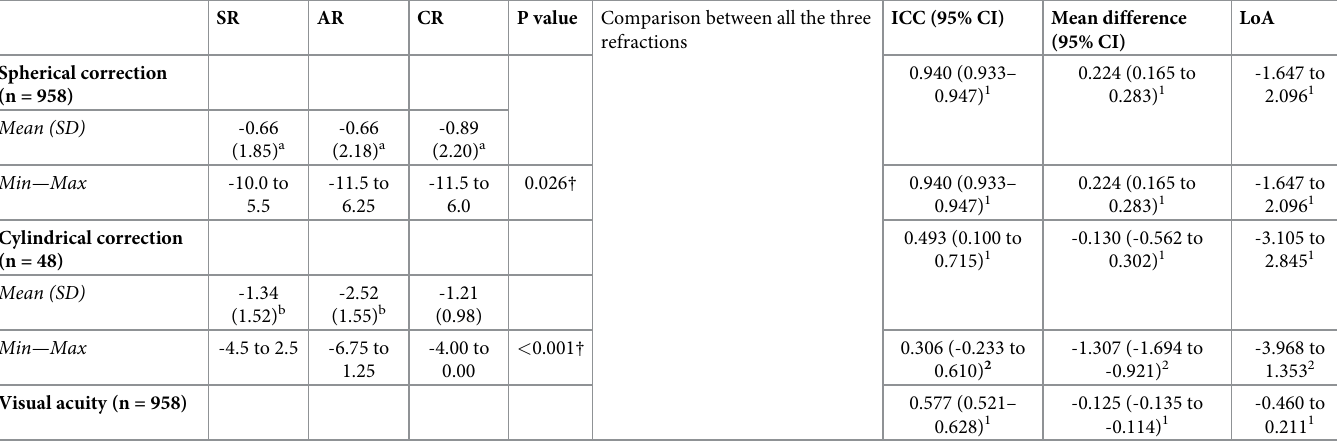
Table 1. Comparison of spherical, cylindrical correction and visual acuity using SR, AR and